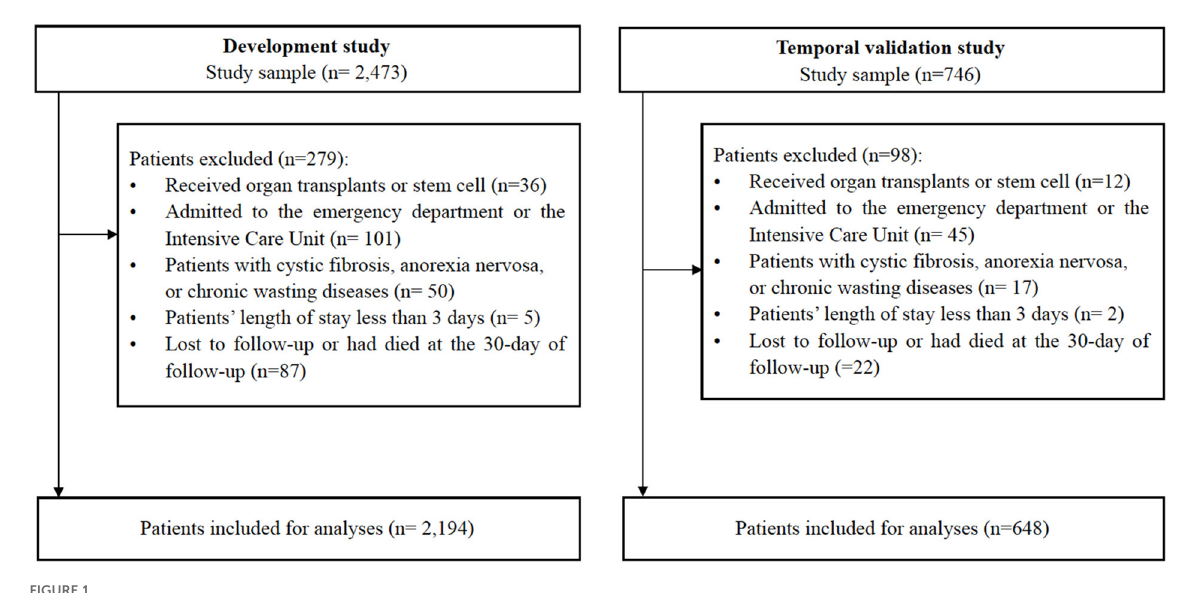
status, depression, red blood cell (RBC), serum albumin, hemoglobin, neutrophils, white blood cell (WBC), number of medications, serum potassium, serum sodium, blood urea nitrogen, creatinine, C-reactive protein, BMI, education level, smoking, and alcohol